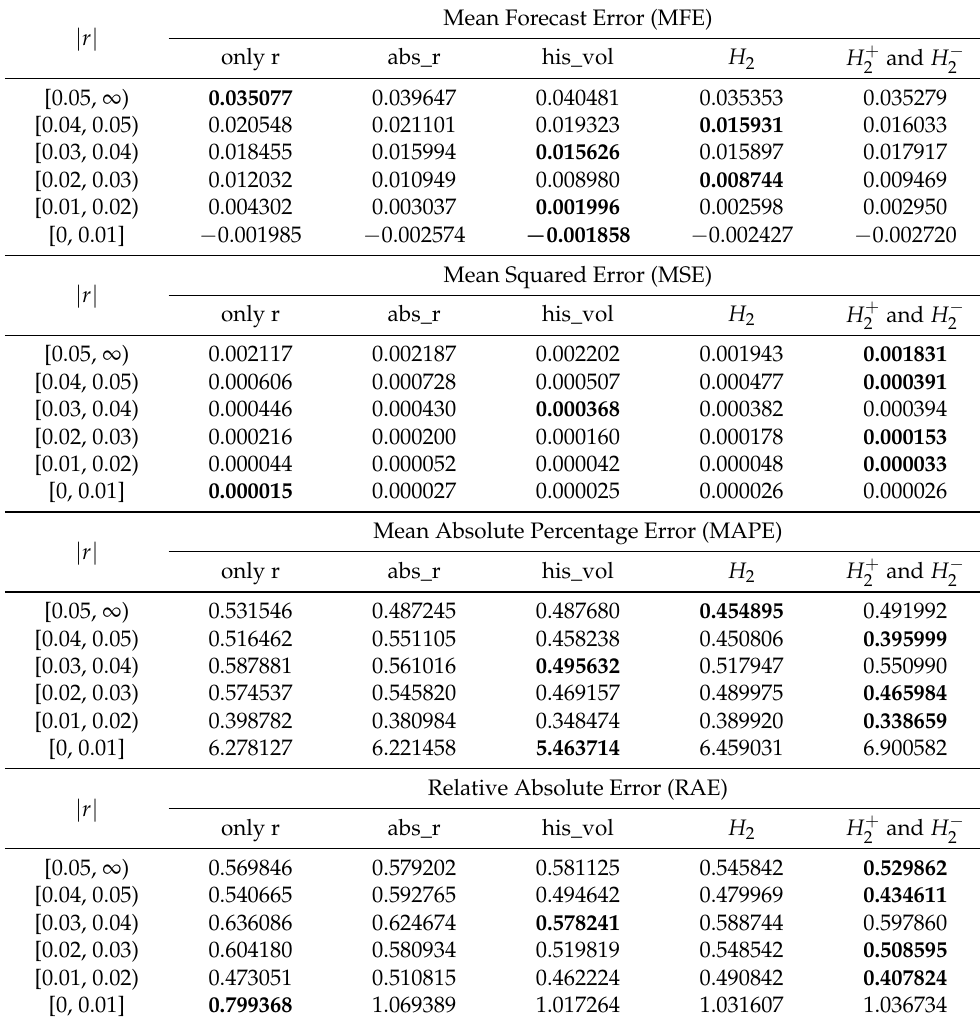
Table 5. Forecasting performance by absolute return with different inputs (Please note that: the best results are highlighted in BOLD